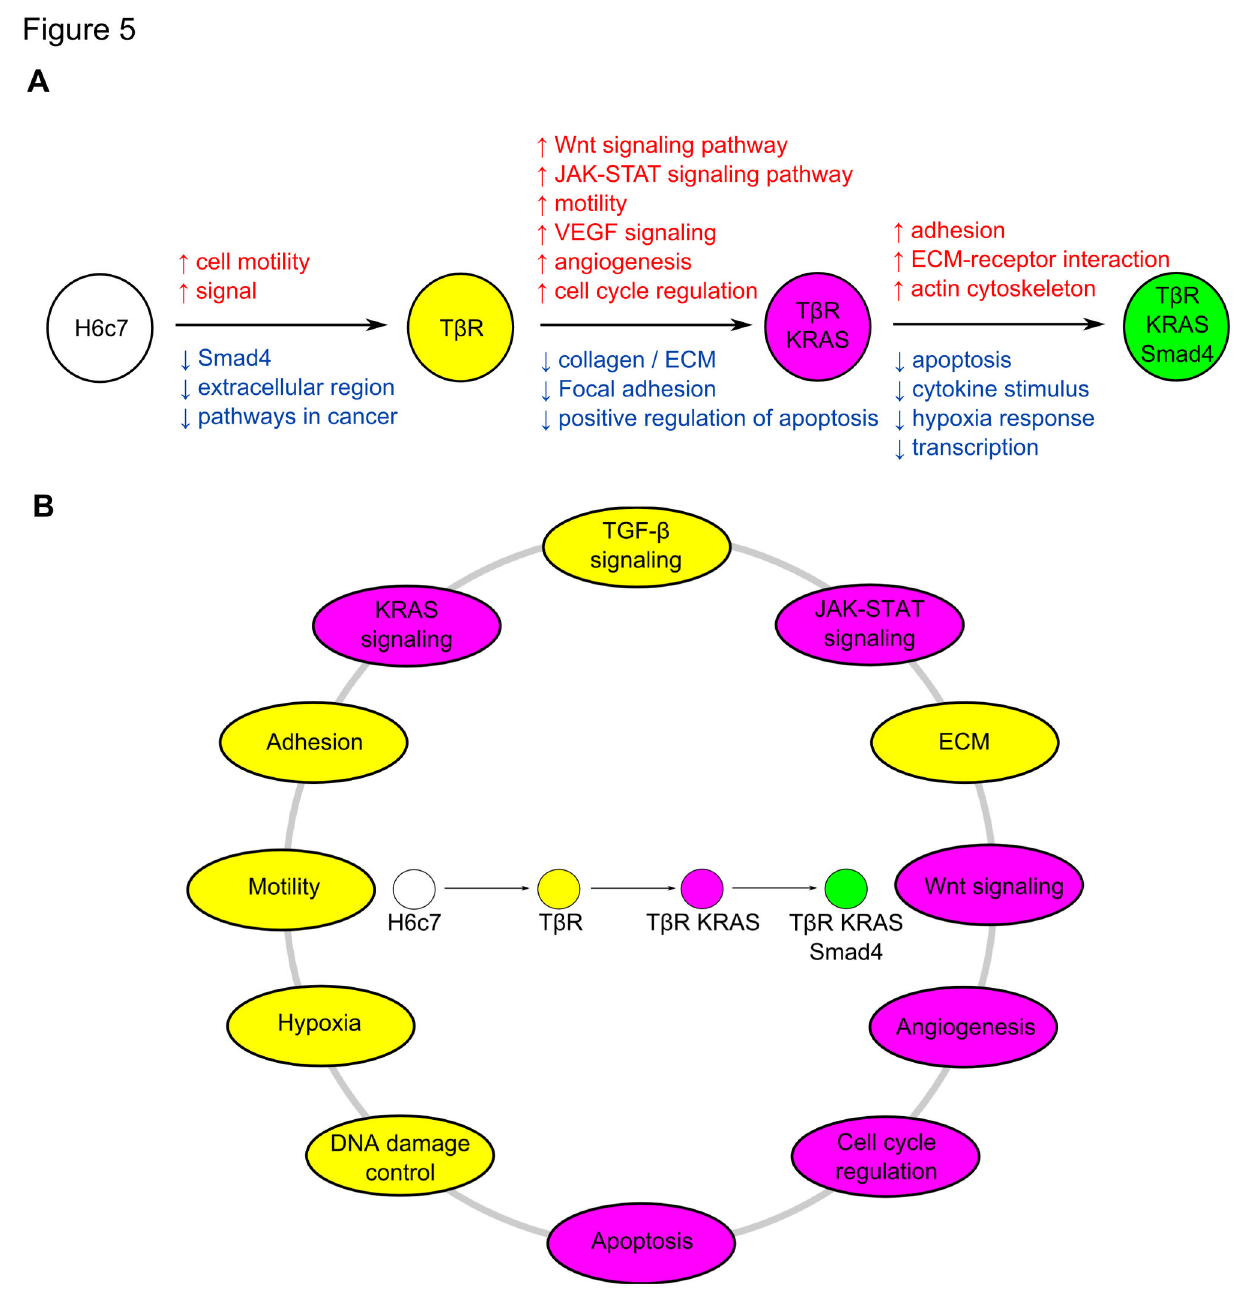
Figure 5. The gene expression changes due to Smad4 loss and KRAS G12V expression. ( A ) The evolution from normal pancreatic duct epithelial cell to tumor cell line. The pathway alterations found in the analyses of the genomic and expression arrays between each transition are listed above the arrows. The red and blue alterations represent gains or upregulation, and losses or downregulation, respectively. ( B ) The pathways that were altered in the pancreatic duct cell carcinogenesis model. Yellow and purple corresponds to changes seen in the TβR and TβR-KRAS cell lines, respectively. doi: 10.1371/journal.pone.0084366.g005 absence is obligatory and serves as a restriction point for malignant transformation in a newly derived Smad4 deficient KRAS -mediated malignant transformation of the HPDE cell H6c7-TβR cell line. As H6c7 cells have already manifested deregulated Rb and p53 pathways, we conclude that Smad4